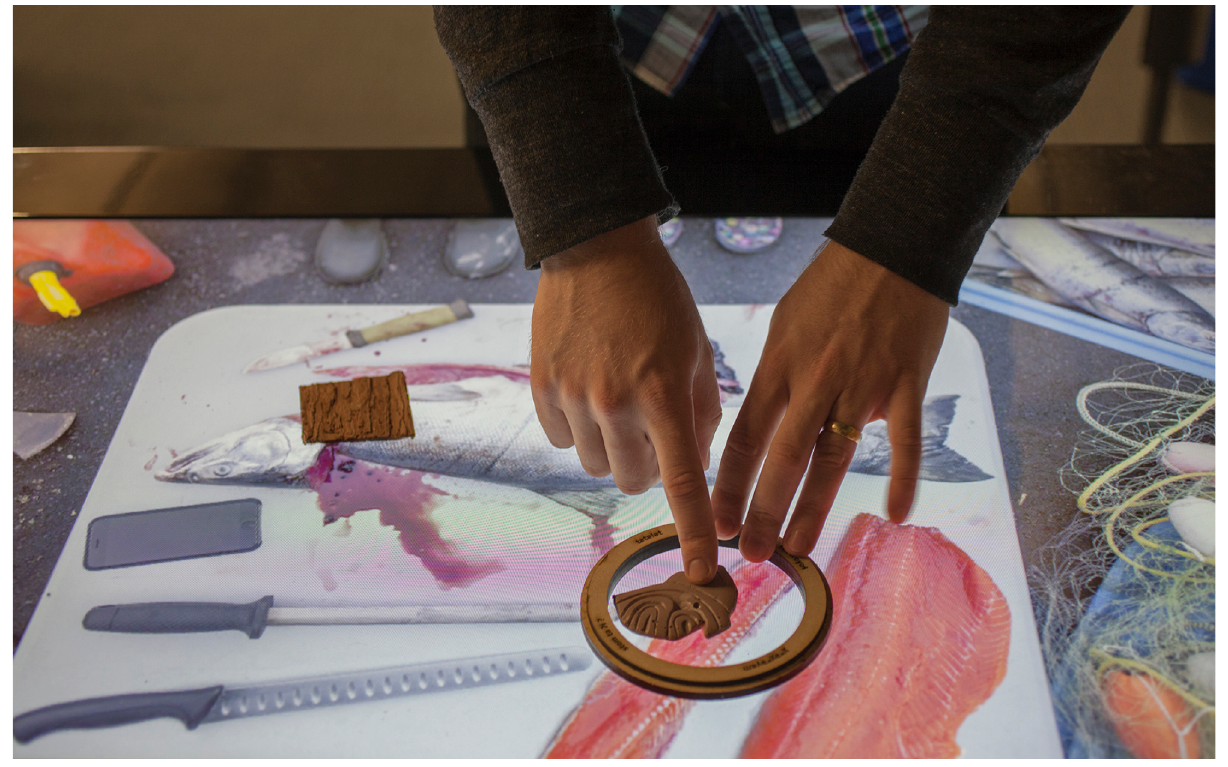
Figure 1 | Testing ring and belonging prototypes for ʔelə w̓k̓ ʷ – Belongings . Courtesy Reese